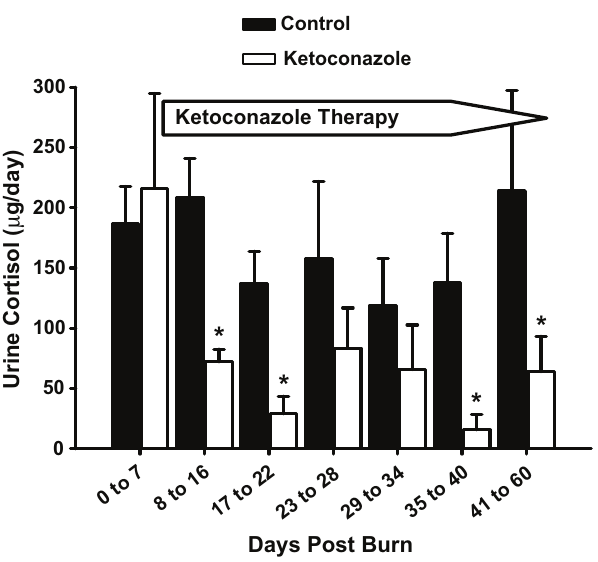
muscle catabolism was similar with or without ketoconazole The data suggest that the increase in muscle catabolism seen with severe burn injury is not mediated by elevated cortisol levels.